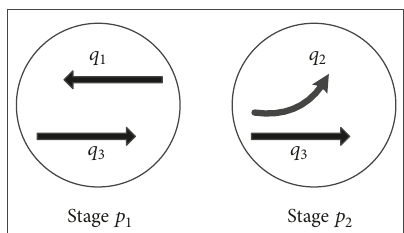
Figure 1: An example of two stages sharing movements [38].